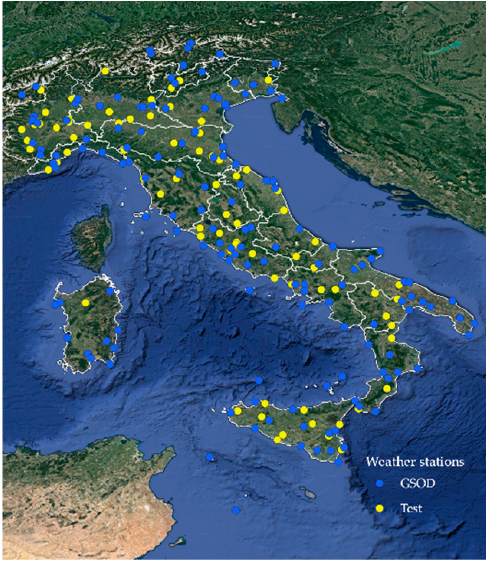
Figure 3. Calibration (GSOD) and validation (test) weather stations for ITGD. Table 2. Networks of the test stations (N = number of stations considered). Network